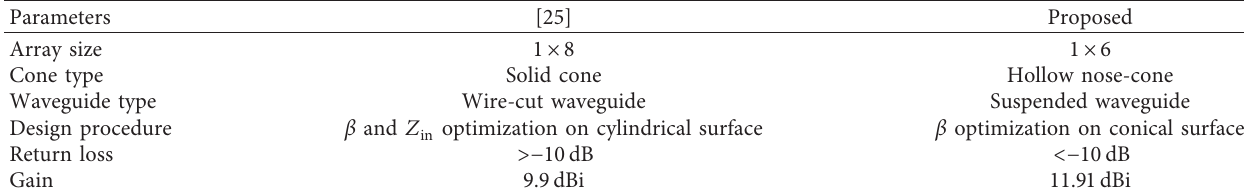
Table 4: Comparative study of proposed and previously presented antenna